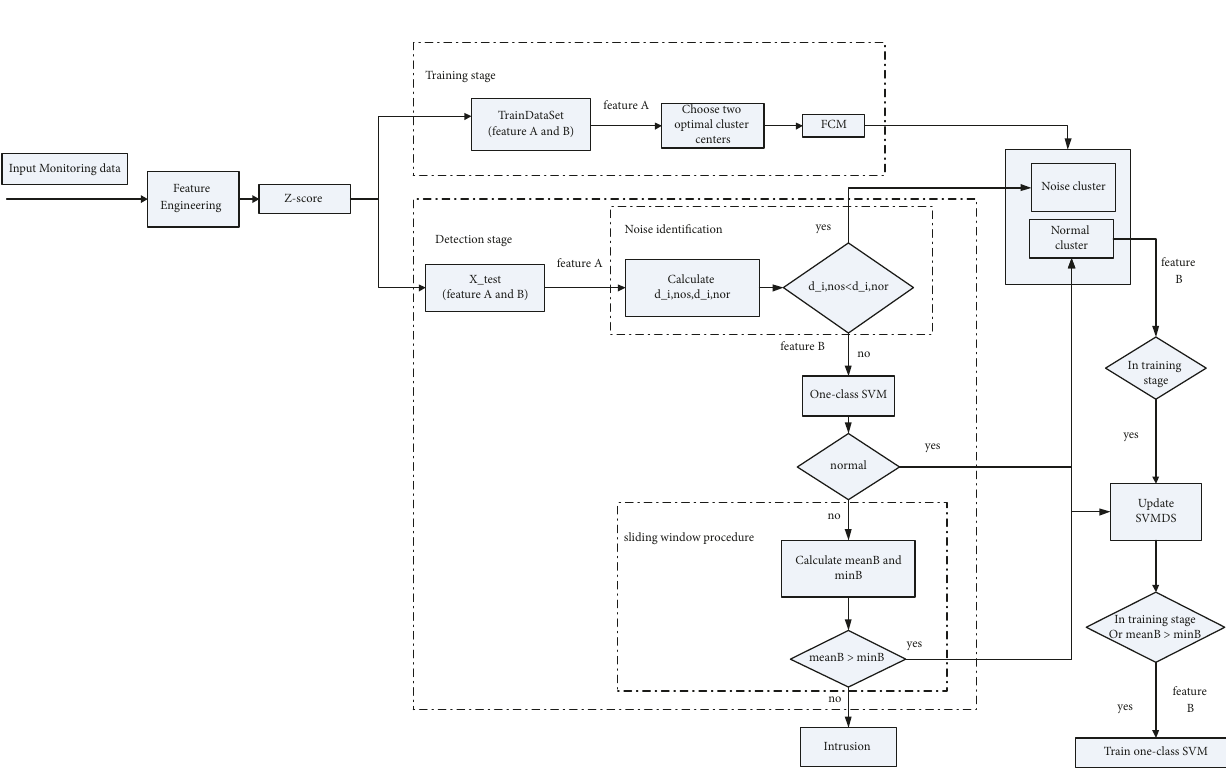
Figure 1: Structure diagram of the proposed intrusion detection